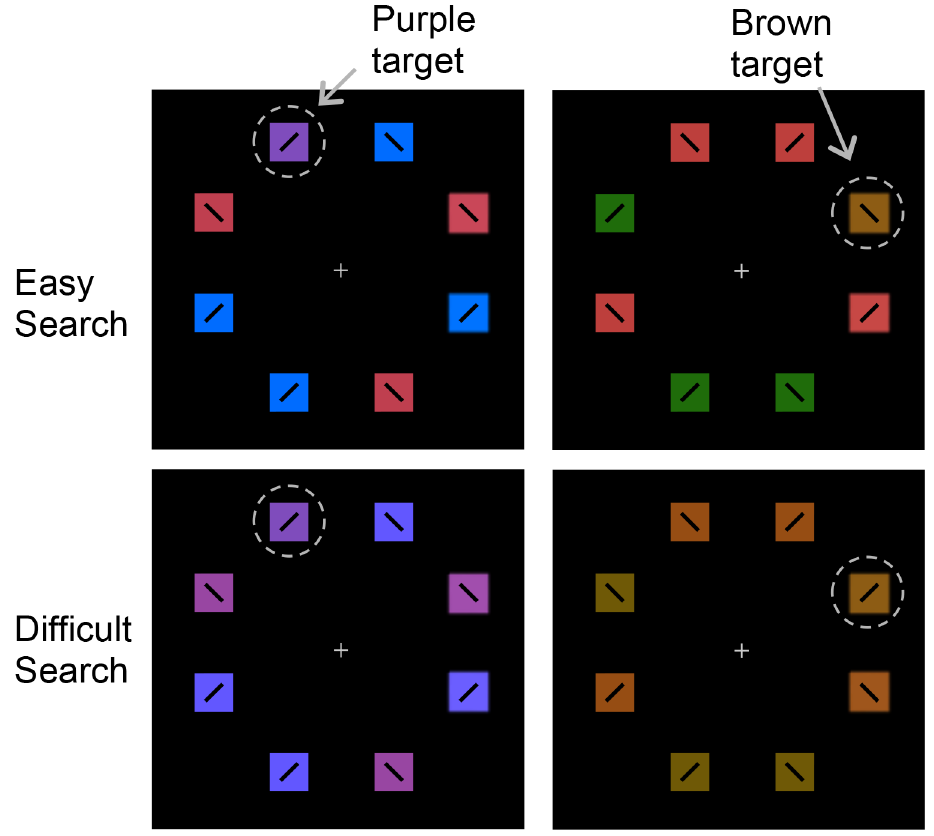
Fig 6. Examples of Experiment 3 stimuli. Target-distractor color similarity was staircasedto fix accuracyat 85% in easy search and 65% in difficult search.